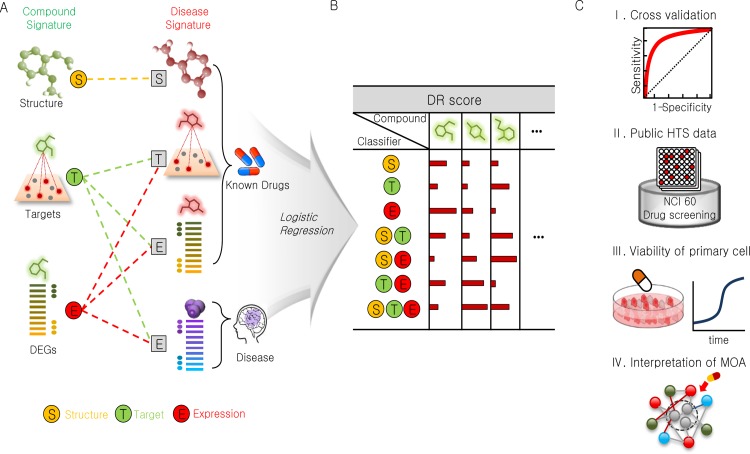
Overview of the in silico DR procedure.(A) The structural (S), target (T), and expression (E) signatures for each compound (circles on the left) and disease (squares on the right) were compared. The associations are indicated by dashed lines in three categories (S: yellow, T: green, E: red) depending on the type of compound signature. (B) In total, seven different classifiers were constructed based on the similarity between the compound and the target signature or their combinations (S, T, E, ST, SE, TE, and STE). The DR scores were calculated using a series of classifiers based on a logistic regression with the known drug set (KD set) used as a benchmark. (C) The performance was evaluated using three independent datasets: I) the mean AUC of 100 rounds of 3-fold cross validation, II) comparison with the 29 sets of NCI-60 DTP human tumor cell line HTS data, and III) experimental validation of anti-proliferative activities using cancer cell lines and primary cells. A pathway-level interpretation of the drug mode of action was performed for active DR candidates for glioblastoma (IV).